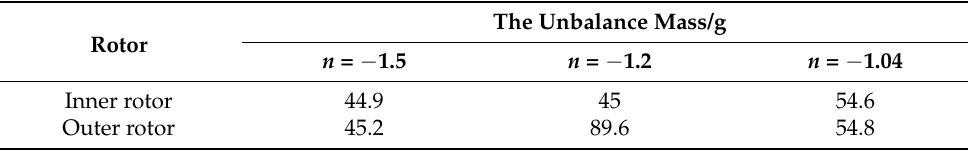
Table 3. The unbalance mass of inner and outer rotors at each speed ratio.